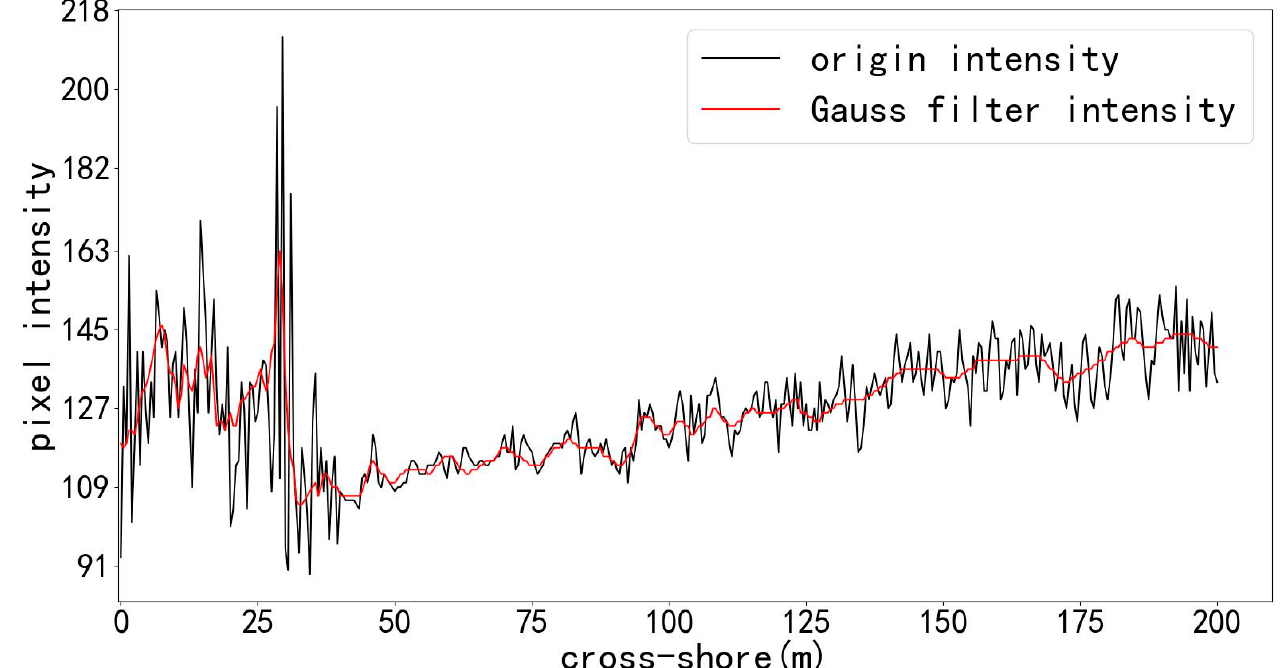
Figure 10. Comparison between Gaussian low-pass filtered signal and the original signal.